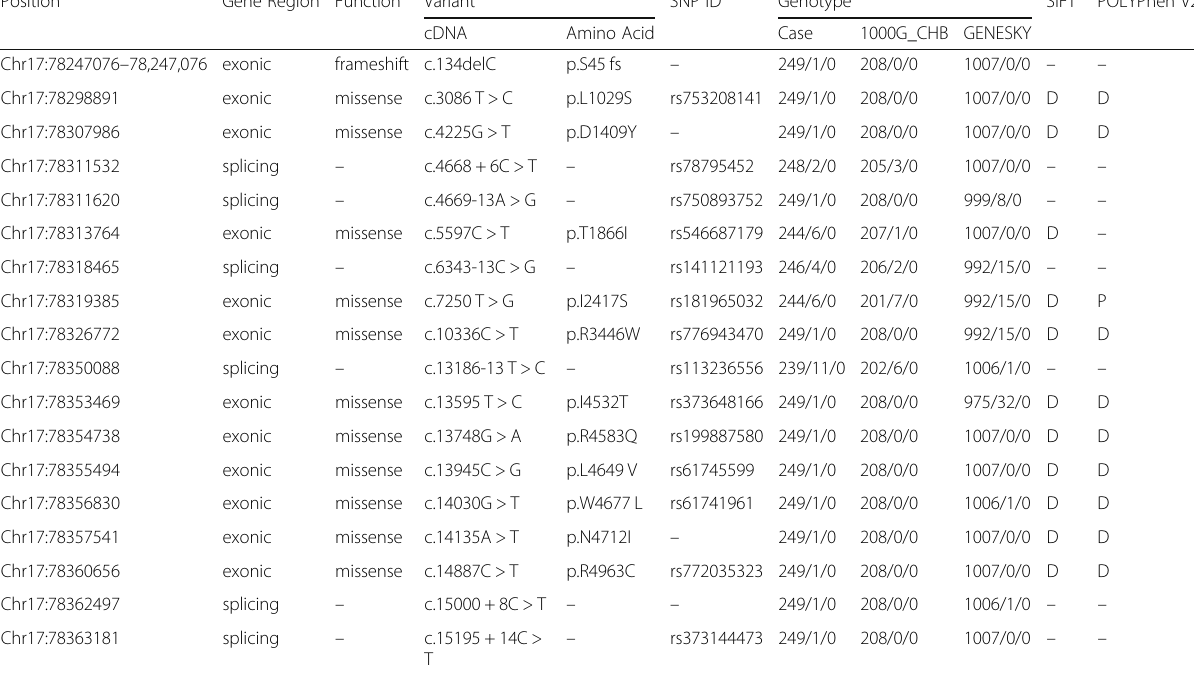
Table 3 Rare variants detected in ICASO